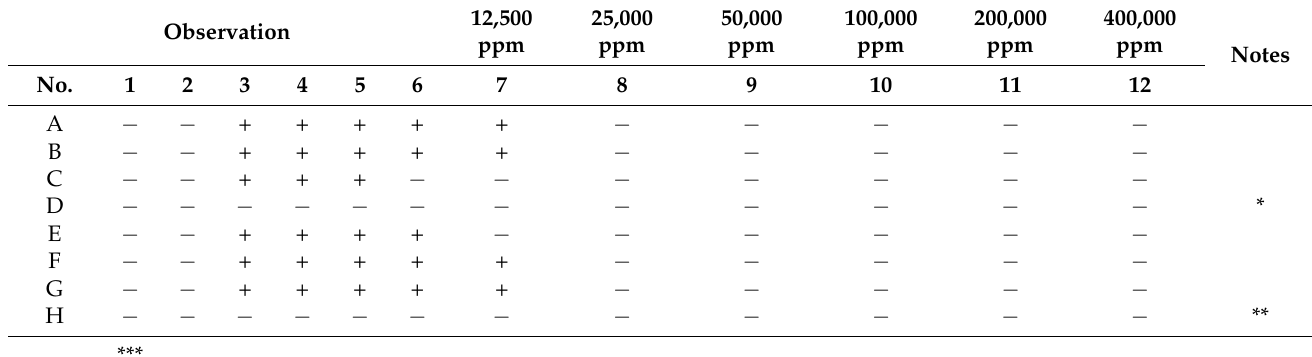
Figure 2. Secondary electron micrographs of ( a ) TS-WPC and ( b ) MTA samples, ( c ) backscattered electron micrograph of TS-WPC, ( d ) elemental mapping of bismuth on the TS-WPC sample. All the sample pictures are from before hydration. Table 2. Minimum bactericidal concentration of the TS-WPC